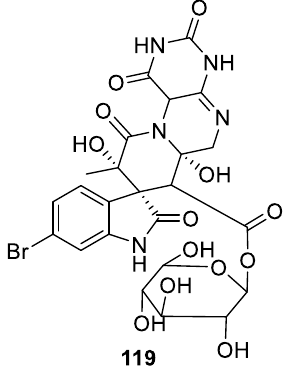
Figure 56. Surugatoxin isolated from the toxic Japanese ivory shell ( Babylonica japonica ).